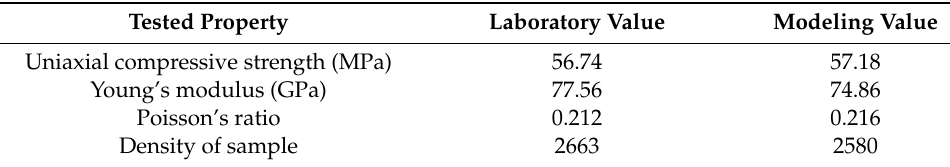
Table 3. Macroscale properties of